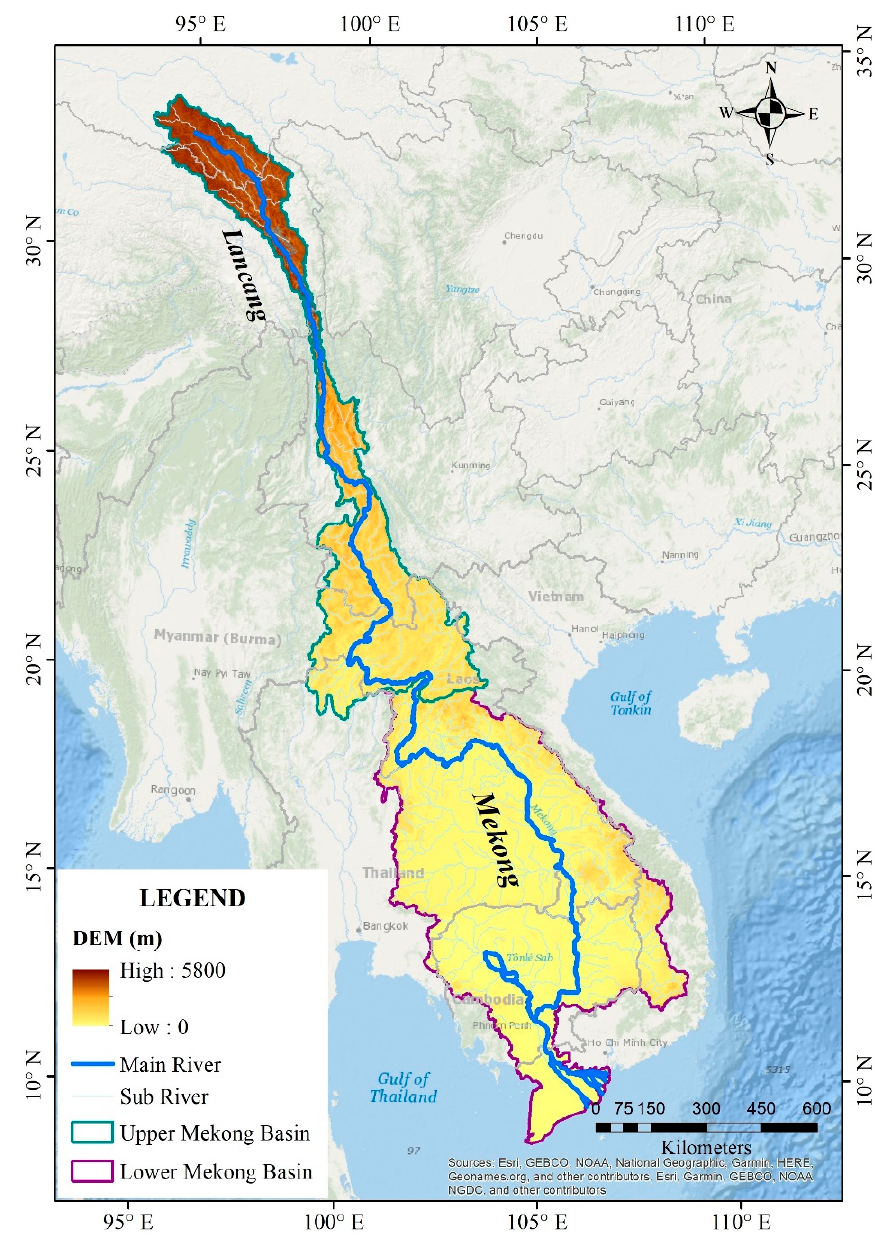
Figure 2. Location of MRB.